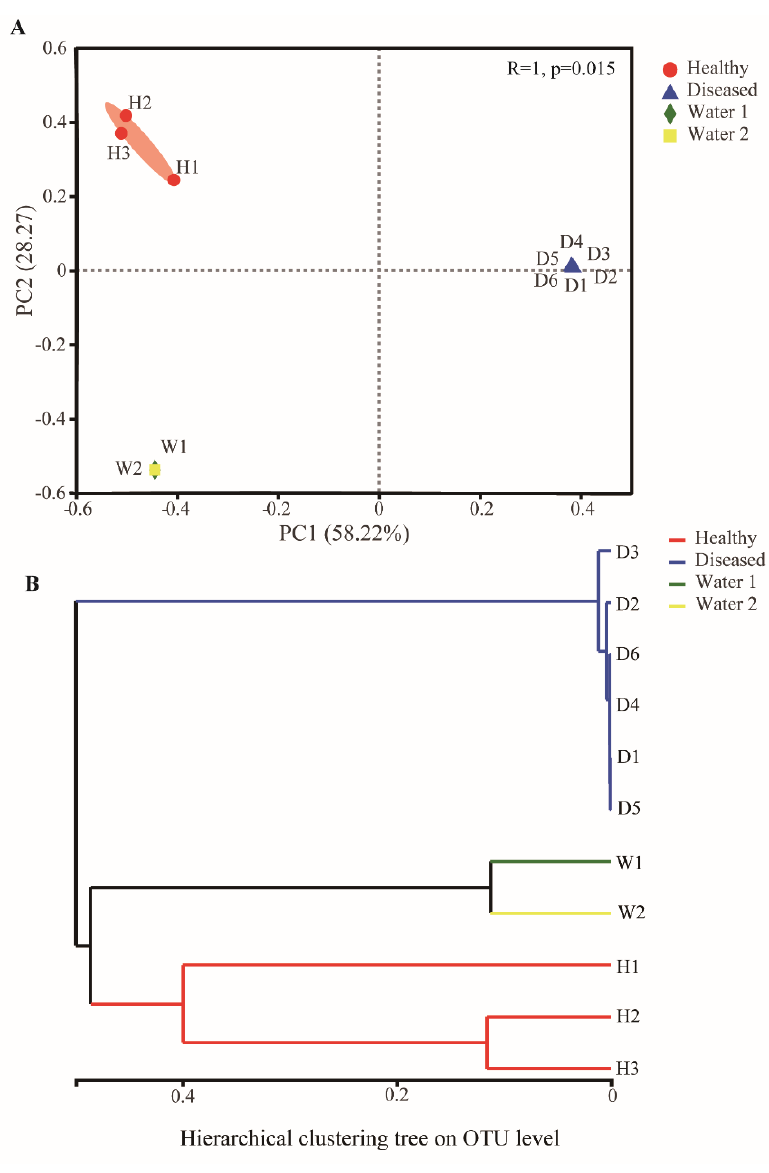
Figure 2. Analysis of the bacterial community structure in different groups. ( A ) Principal coordinate analysis based on the Bray–Curtis metric of the bacterial communities in the intestine and water. ( B ) The hierarchical clustering tree based on Bray–Curtis metric of the bacterial communities in the intestine and water.